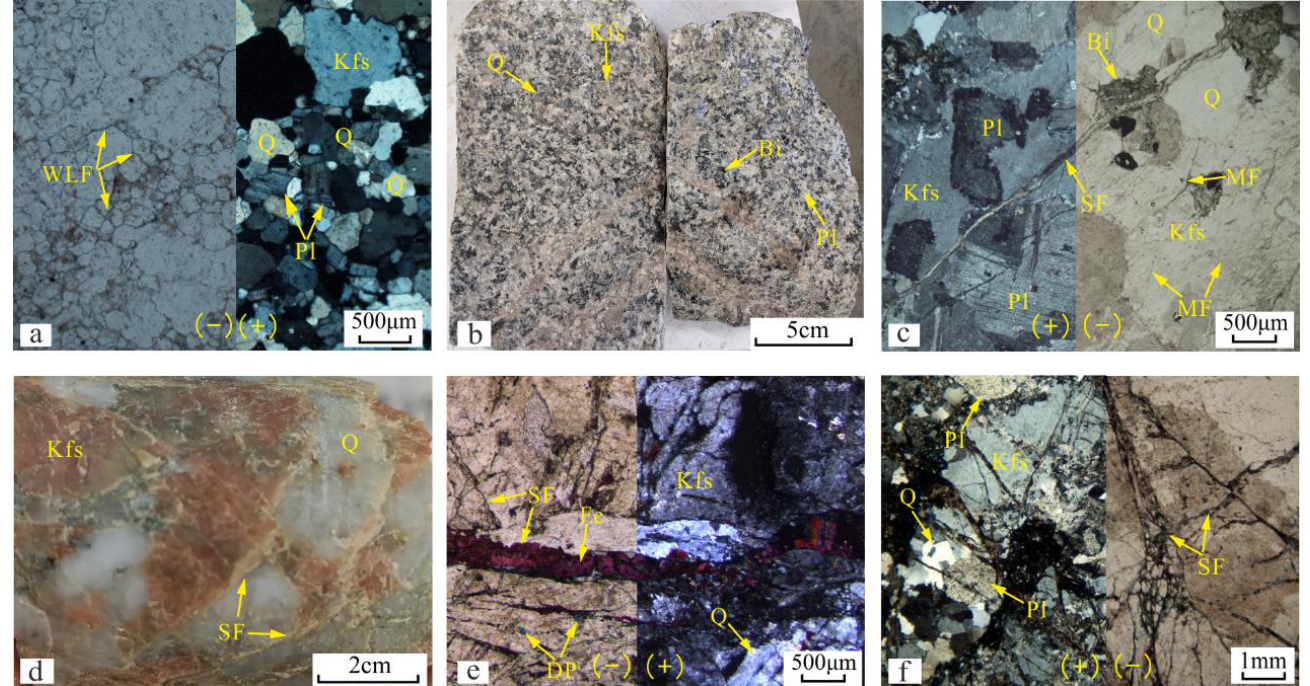
Figure 2. Typical photographs of rock types and reservoir spaces of intrusive rock buried-hill in the Y area. ( a ) Monzonitic granite, weathering and leaching fractures, Well Y832, 2883.3 m, sidewall core thin section; ( b , c ) biotite monzonitic granite, structural fractures filled with calcite, potash feldspar with micro fracture, strongly alternated plagioclase, biotite chloritized, Well Y832, 2935 m, core and its thin section; ( d , e ) syenite granite, structural fractures filled with ferrocalcite, Well Y812, 3439.3 m, sidewall core and its thin section; and ( f ) cataclastic monzonitic granite, structural fractures, strongly alternated plagioclase, Well Y811, 3003 m, sidewall core thin section. Q—quartz; Pl—plagioclase; Kfs—potash feldspar; Bi—biotite; Fc—ferrocalcite; WLF—weathering and leaching fracture; SF—structural fracture; MF—micro fracture; DP—dissolution pores.